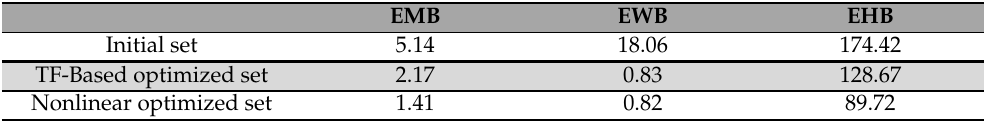
Table 3. Comparison of the amount of energy used in the ramp response for 2 seconds (the amounts are in